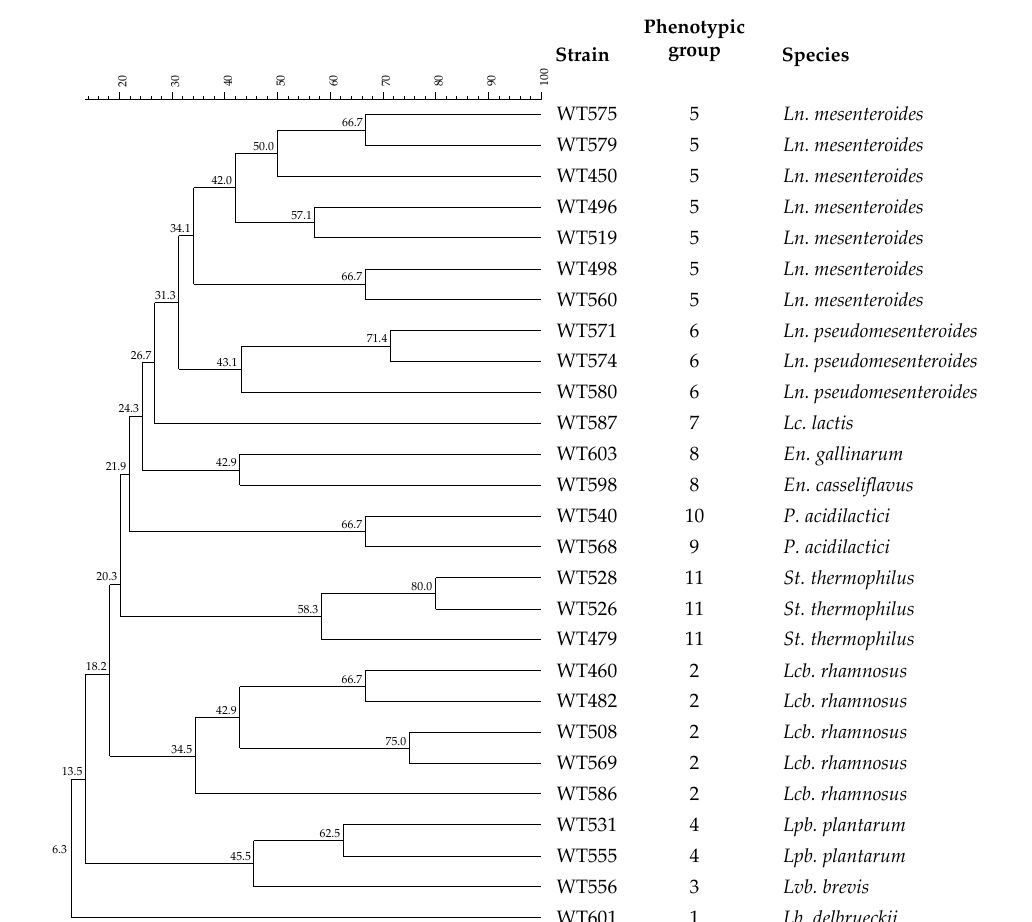
Figure 4. Dendogram obtained from combined RAPD-PCR patterns generated with three primers of the LAB strains identified. Abbreviations: En. , Enterococcus ; Lb. , Lactobacillus ; Lcb. , Lacticaseibacillus ; Lc. , Lactococcus ; Lpb. , Lactiplantibacillus ; Ln. , Leuconostoc ; Lvb. , Levilactobacillus ; P. , Pediococcus ; St. , Streptococcus .